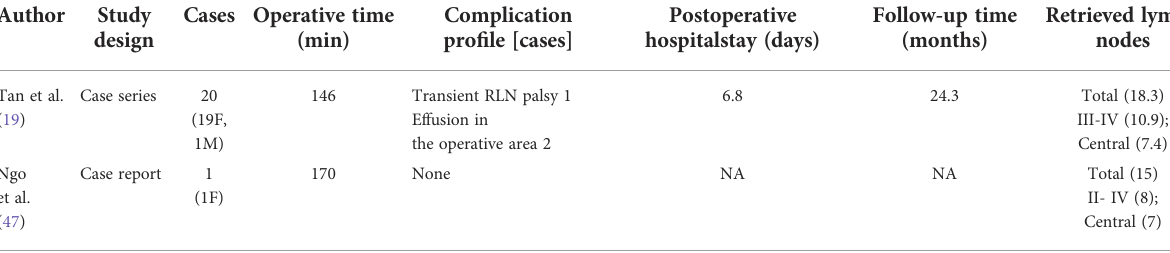
TABLE 8 Summary of studies of endoscopic LND via transoral